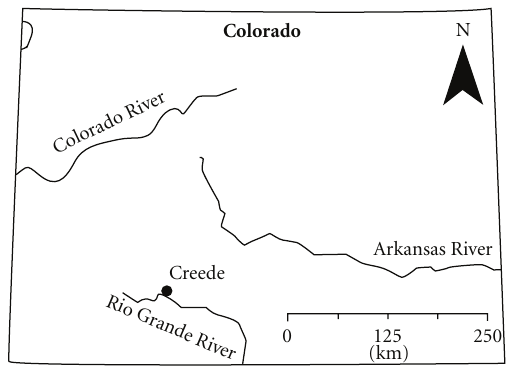
Figure 1: City of Creede, Colorado, part of the historic Creede Min- ing District, is located within the Willow Creek watershed. Willow Creek is formed by the confluence of the East and West Willow Creeks and is a tributary of the Rio Grande